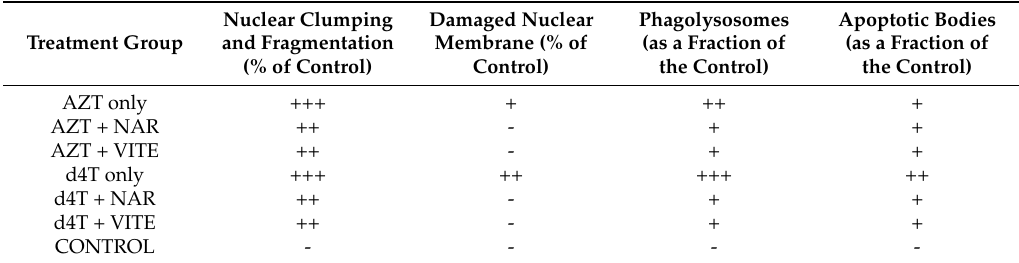
blinded to the experiment carried